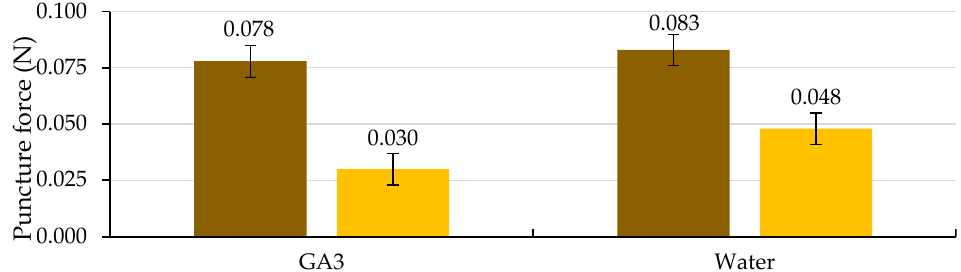
Figure 10. Analysis of the interaction of the analysis of variance in Table 4 between the cracking of the testa (uncracked testa (brown) and cracked testa (yellow)) and the solution used to wet the substrate on the puncture force required to pierce the micropylar endosperm at three days after the cracking of the testa. Average values of four replicates of 10 seeds each. Error bars represent the LSD ( p ≤ 0.05).